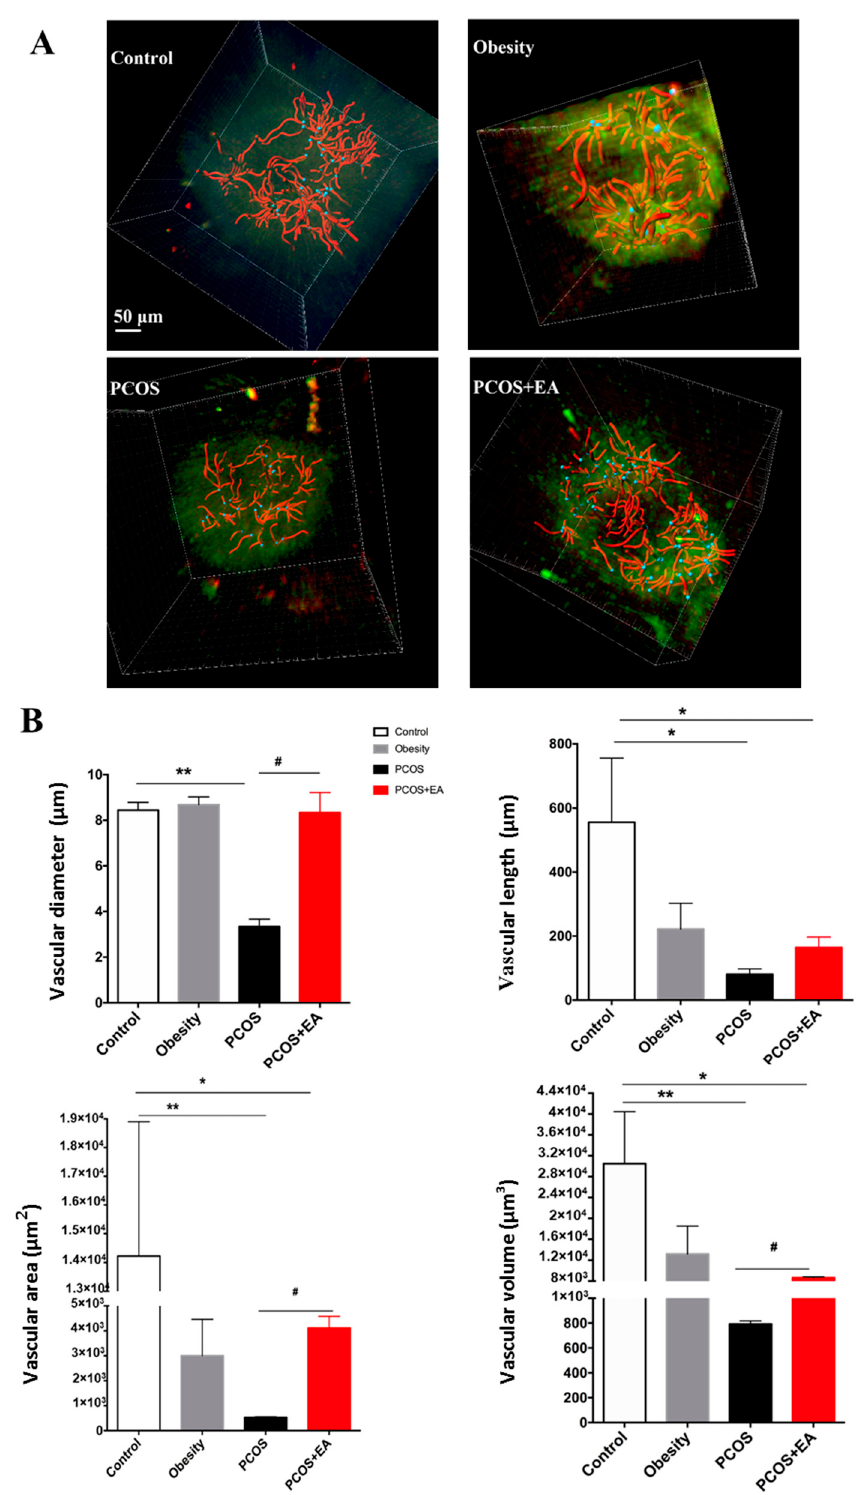
Figure 5. EA promotes angiogenesis surrounding the antral follicles. ( A ) Reconstruction of the neovasculature surrounding the antral follicles. ( B ) Quantification of the diameter, length, area, and volume surrounding antral follicles in the different groups. * p < 0.05 and ** p < 0.01 vs. the Control group; # p < 0.05 vs. the PCOS group.